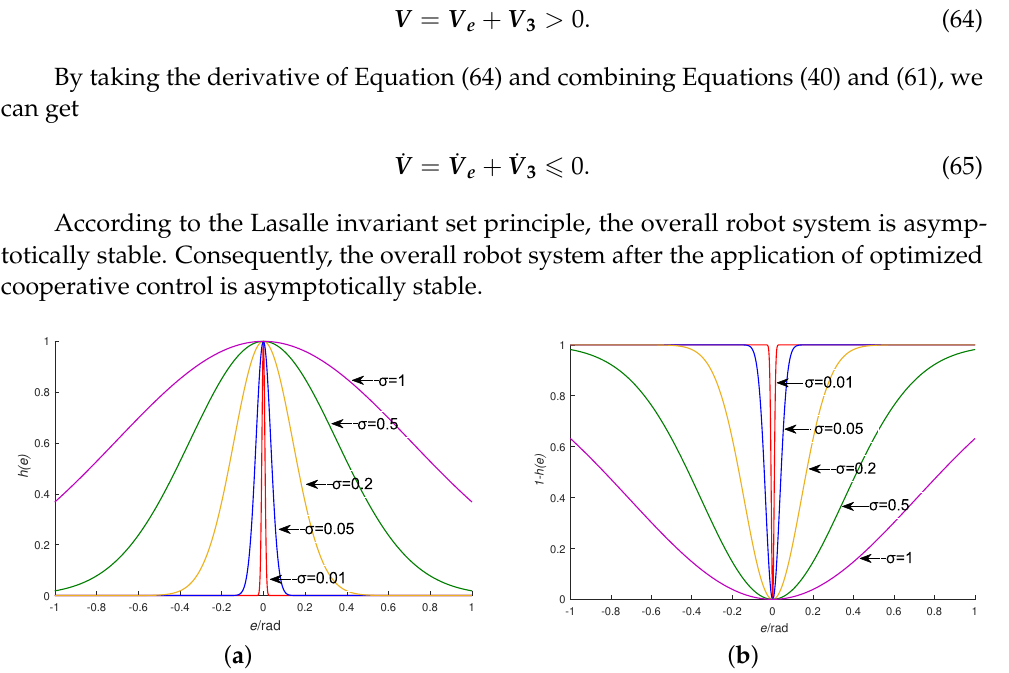
Figure 4. The curves of optimized cooperative control coefficient. ( a ) The function curve of h ( ˜ q ) . ( b ) The function curve of 1 − h ( ˜ q ) .